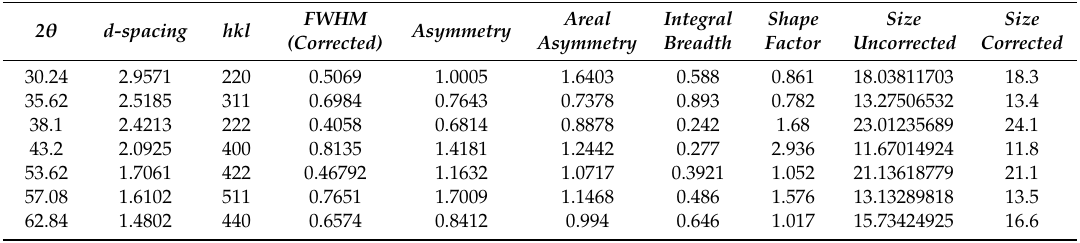
Table 1. Parameters obtained from the XRD patterns of the Fe 3 O 4 NPs and involved in the Williamson-Hall analysis. FWHM: full width at half